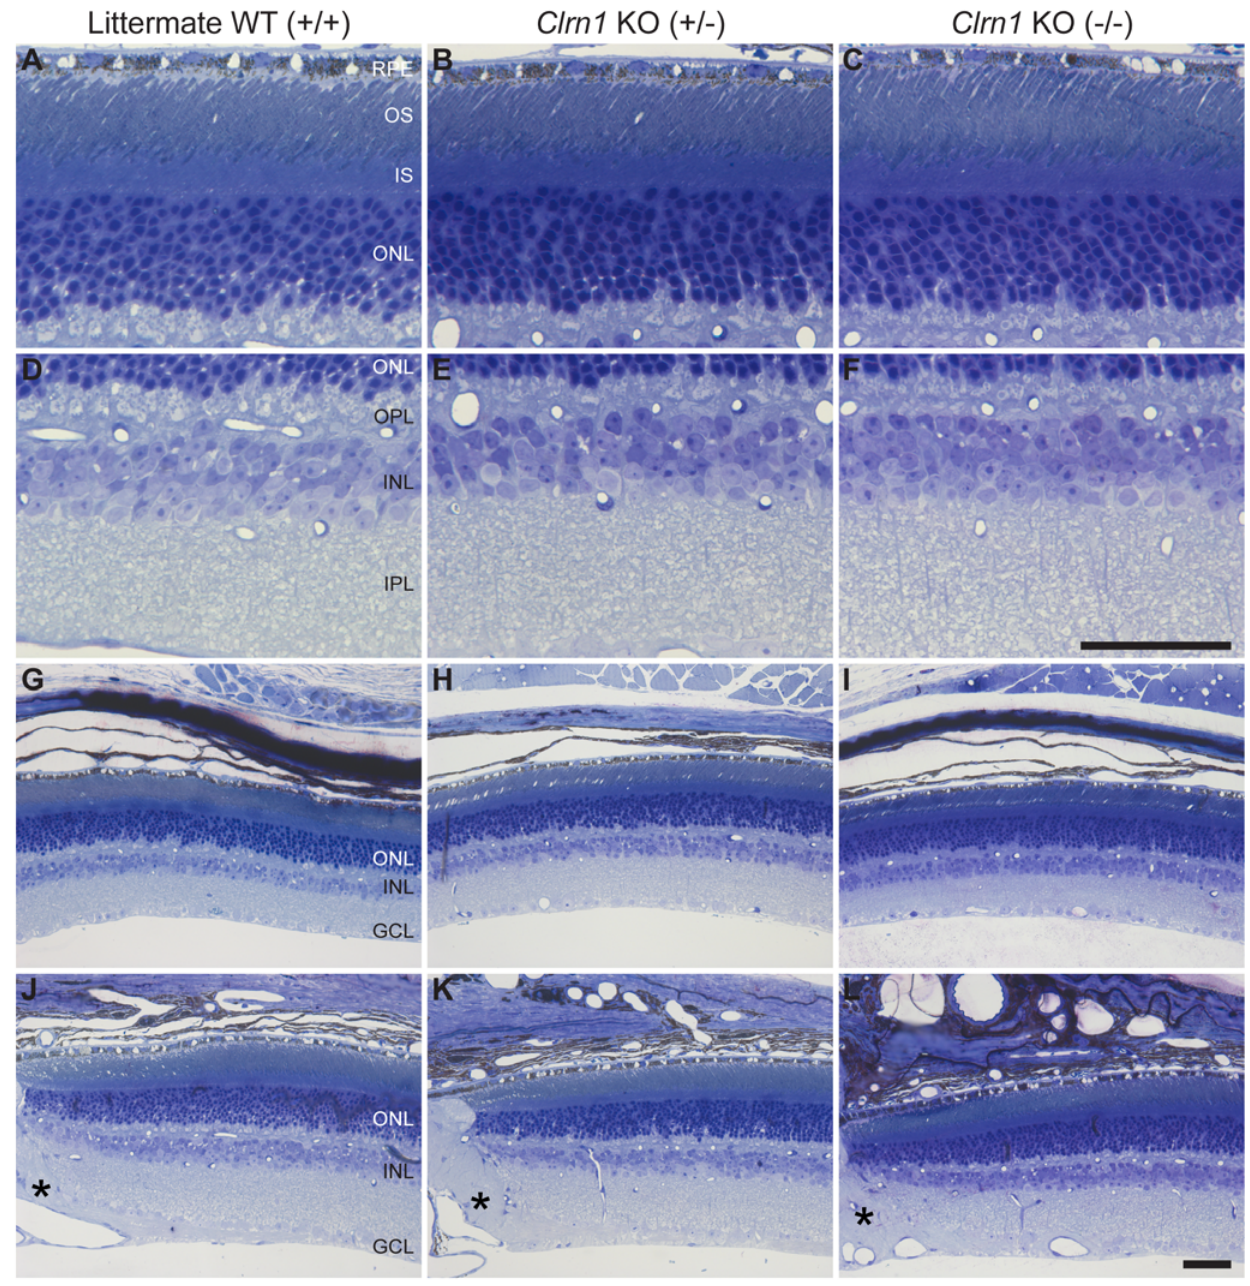
Figure 6. Histological analysis of Clrn1 KO retinas at 9 months of age. (A–C) Compared to WT animals (A), outer retinal histology appears normal in heterozygous (B) and homozygous (C) Clrn1 KO mice. (D–F) Similarly, the inner retina of the Clrn1 KO ( + / 2 , 2 / 2 ) animals is indistinguishable from the WT animal (D). (G–L) When compared to WT ( + / + ) animals (G and J) at lower magnification, gross retinal structure seems unperturbed by the lack of Clrn1 expression (H,I,K,L) in either mid-peripheral retina (G–I) or central retina (J–L) immediately adjacent to the optic nerve head (asterisks). Scale bar=50 m m. ONL=outer nuclear layer, IS=photoreceptor inner segments, OS=photoreceptor outer segments, and RPE=retinal pigmented epithelium. (Figure S4), driven by the human cytomegalovirus (CMV) upon the primary structure[12], as well and recent studies [23], that full-length murine CLRN1 (232 aa) is predominantly a immediate early promoter. Transfection with the vector alone plasma membrane-targeted protein. resulted in EGFP expression localized throughout cell somata (Figure S4A). CLRN1 (containing exons 1, 3, and 4) was fused to Anti-CLRN1 antibodies were screened for specificity using the 3 9 end of EGFP, and following expression the resultant fusion- EGFP-CLRN1 transfections in HEK293 cells. With the red protein was redistributed and concentrated to plasma membranes channel turned off, clear EGFP-CLRN1 fluorescence is observed in a subset of cells (Figure S4C). Red fluorescence (Figure S4D) (Figure S4B). This finding supports previous predictions based